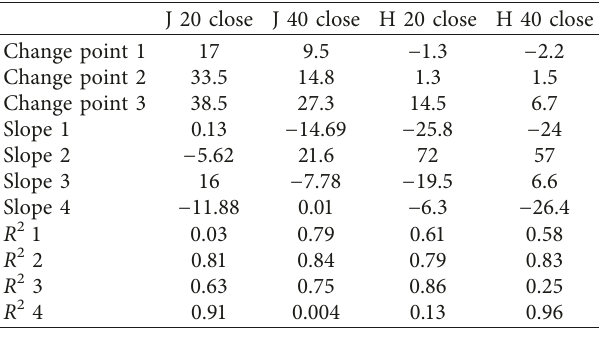
Table 4: Results of change point analysis for closure of 20 and 40dB Z regions with time of change point in hours after landfall, slope of trend line in between each change point in hr − 1 , and the coefficient of determination for each trend